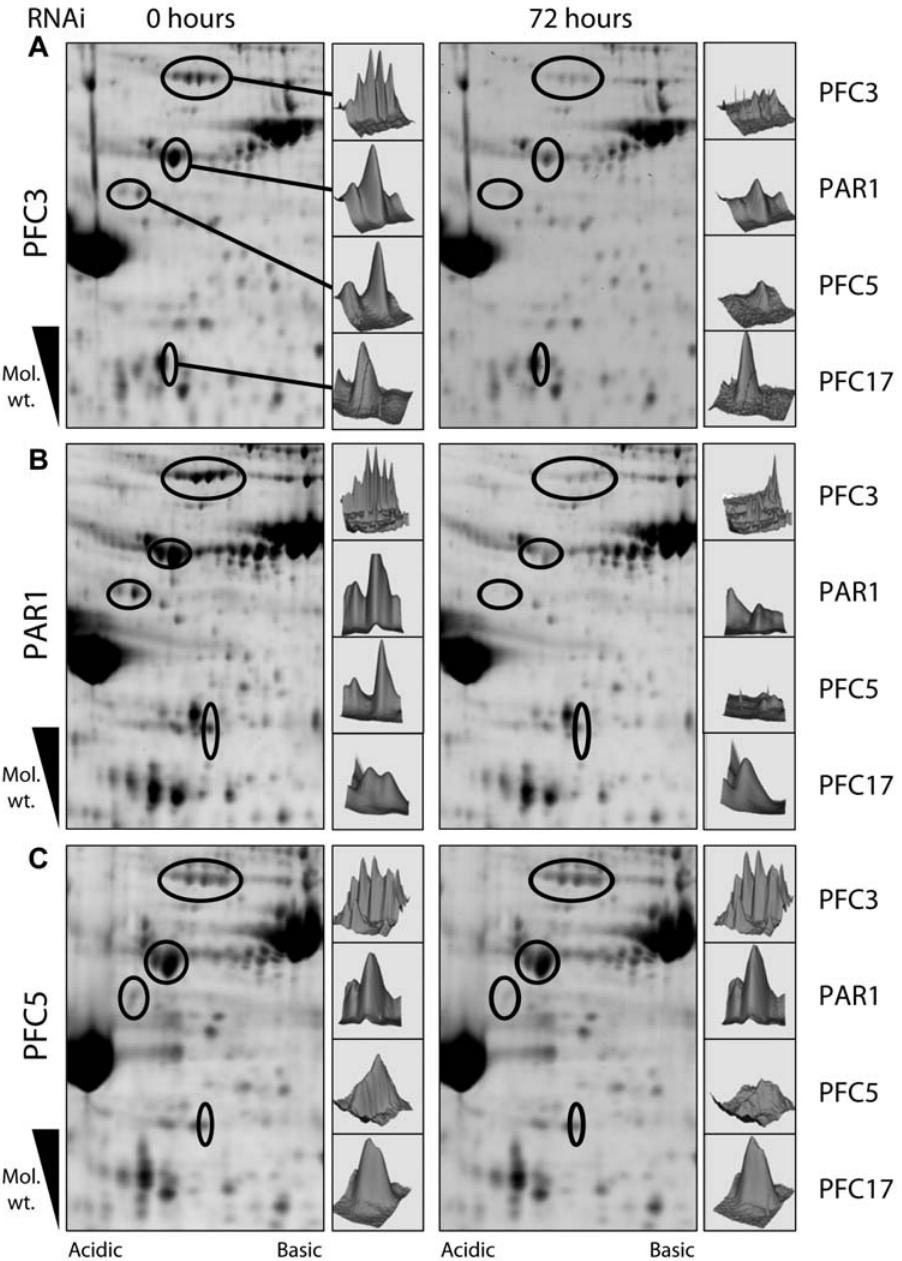
Figure 4. Two-dimensional DiGE analysis of PFC3, PAR1 and PFC5 non-induced and RNAi induced flagella. The gels were analyzed using Decyder software (GE Healthcare), which was used to generate three-dimensional representations of the spots that show a change in volume after induction. Reductions in volume were seen for spots corresponding to PFC3, PAR1, PFC5 and PFC17 in both PFC3 and PAR1 RNAi induced environments. Reduction in volume was seen only for spot corresponding to PFC5 following RNAi ablation of